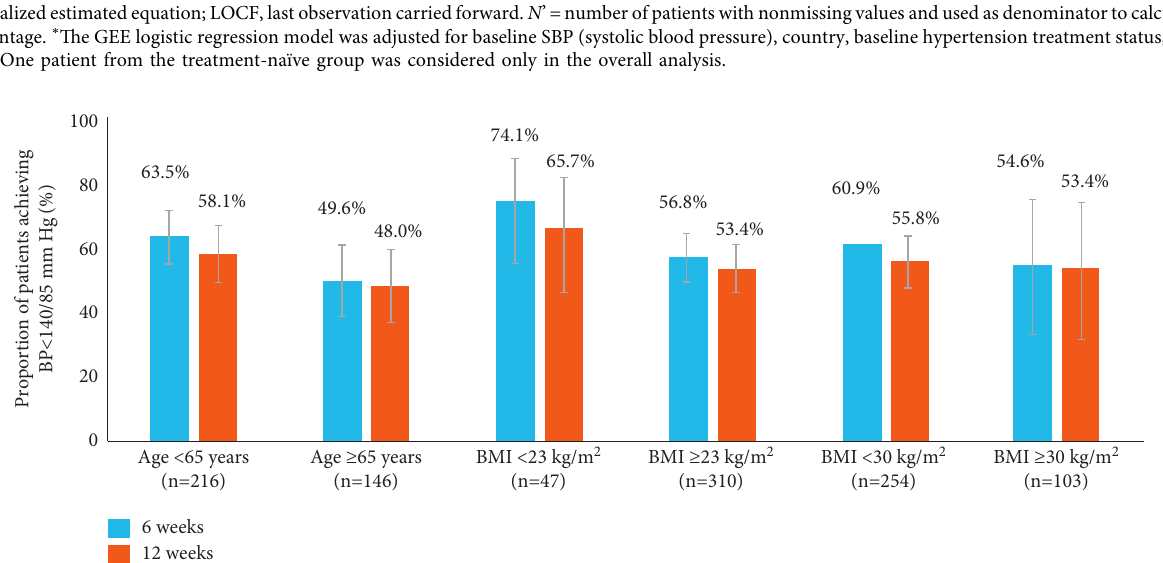
Figure 2: Percentage of patients with trough BP < 140/85 mm Hg by age and BMI subgroup analysis using GEE (logistic regression analysis): FAS and LOCF and number of patients with nonmissing values and used as denominator to calculate percentage. The percentages and 95% confidence intervals are shown. BMI, body mass index; FAS, full analysis set; GEE, generalized estimated equation; and LOCF, last observation carried